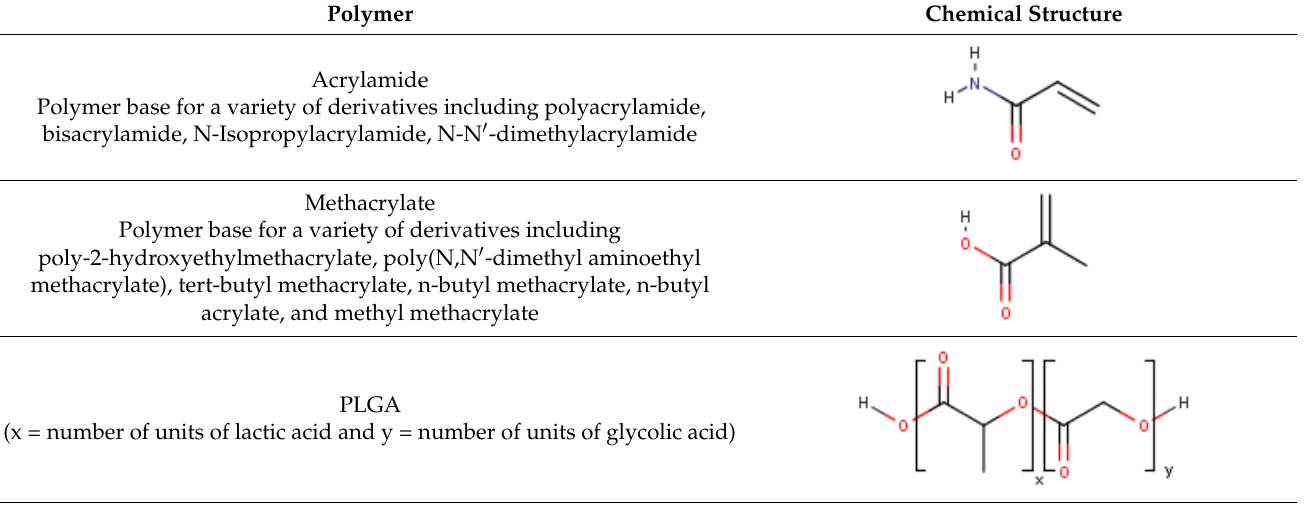
( n = number of units of ethylene glycol)